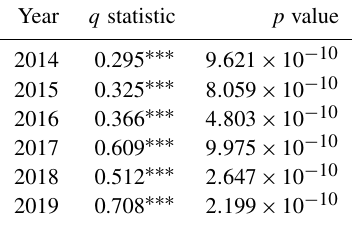
Table 1. The q statistic and p value calculated by the geographi- cal detector, which indicate the SSH of annual May-to-September mean surface ozone concentrations in China. ∗ , ∗∗ , and ∗∗∗ of the p value indicate statistical significance at the α = 0 . 05 ∗ , 0.01 ∗∗ , and < 0 . 001 ∗∗∗ level,